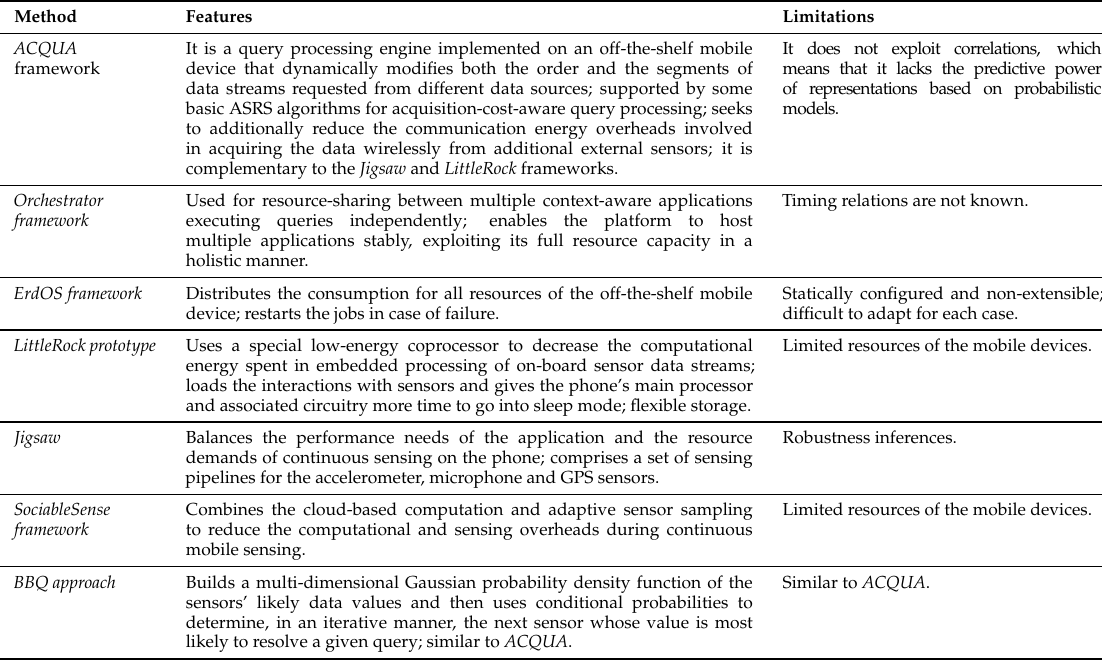
Table 2. Examples of data acquisition methods. ACQUA , Acquisition Cost-Aware QUery Adaptation ; ASRS, automated storage and retrieval